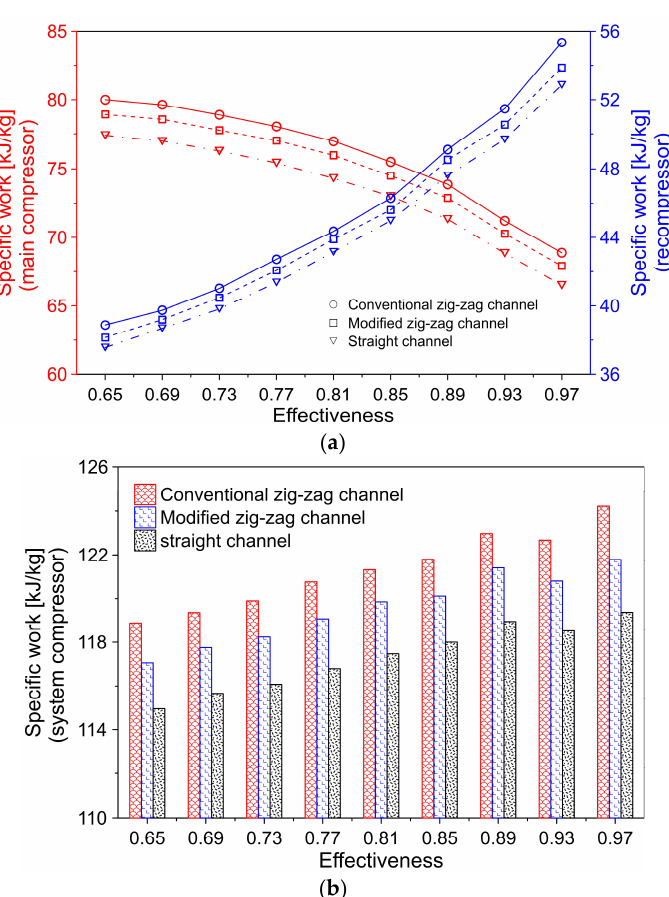
Figure 18. Specific work: ( a ) main compressor and recompressor; ( b ) compression system.